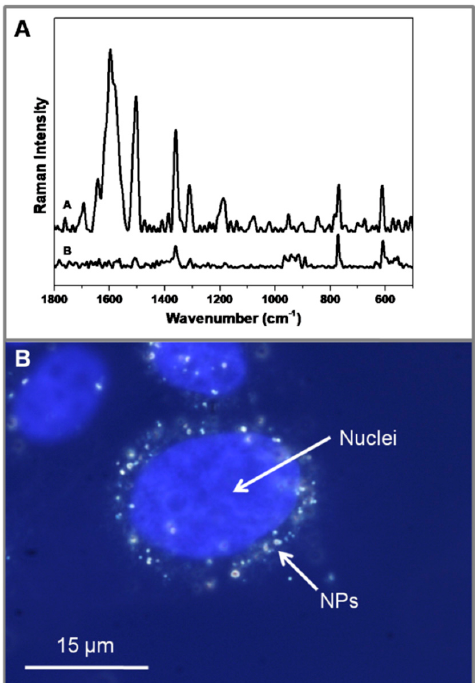
Figure 5. SERS spectra of AgNP@R6G@BSA ( A . Inset A) and AgNP@R6G@BSA-treated human carcinoma cell line (A431) ( B . Inset B). Overlay images of blue fluorescence channel (Hoechst dye labelling cell nuclei) and dark field microscopy (DFM) reveal nanoparticle